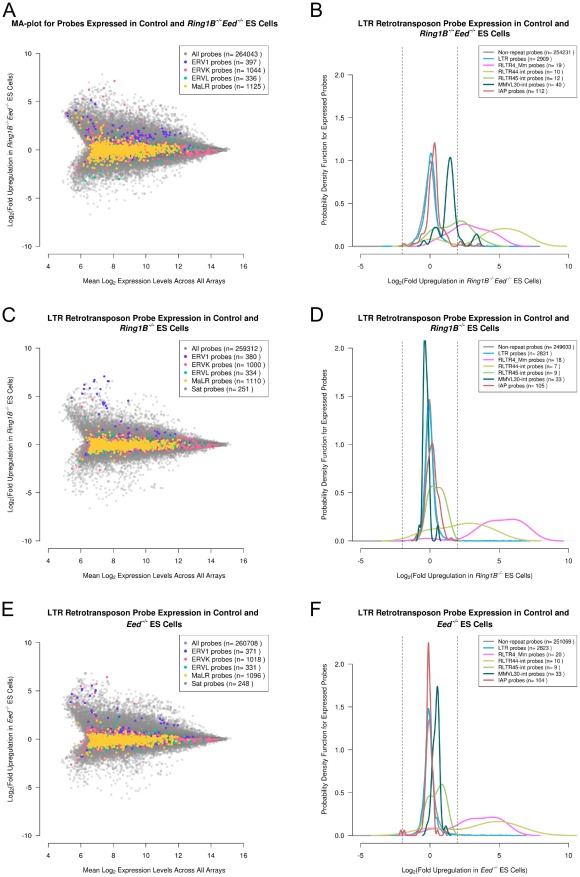
LTR retrotransposon targets of polycomb repressive complexes in ES cells.(A, C, E) MA-plots for Ring1B−/− Eed−/− double knockout, Ring1B−/− single knockout and Eed−/− single knockout ES cells showing how different classes of LTR retrotransposons change expression in these cell lines. (B, D, F) Plots showing the behaviour of selected retrotransposon probe populations in Ring1B−/− Eed−/− double knockout, Ring1B−/− single knockout and Eed−/− single knockout ES cells. The selected retrotransposons are all represented by multiple upregulated probes (≥4 fold upregulation, p<0.01) in Ring1B−/− Eed−/− ES cells. Vertical lines indicate a 4 fold change. Note that some retrotransposons (e.g. MMVL30, RLTR45) are upregulated in double knockout but not single knockout ES cells, other retrotransposons (e.g. RLTR44) are upregulated in all three ES cell lines. Retrotransposon probes are colour-coded as shown in the plot legends.